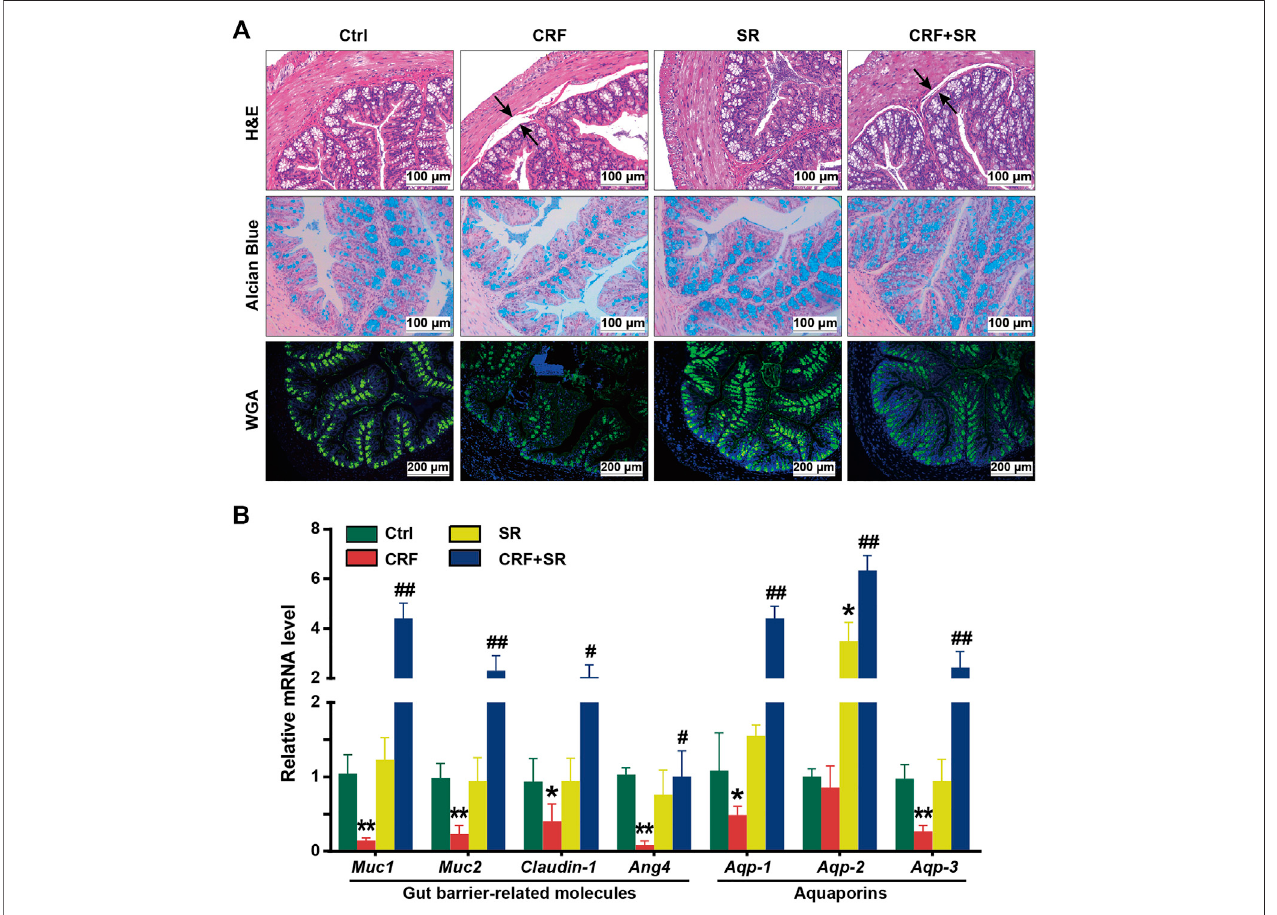
FIGURE 4 | Protection of gut barrier damage in colon of CRF mice by SR decoction. (A) Morphology of colon tissues by using H&E staining (200 ×), Alcian blue staining (200 ×), and WGA-FITC staining (100 ×). Black arrows, indicating intestinal edema. (B) Expressions of gut barrier-related molecules and aquaporins in colon tissues at mRNA level by RT-qPCR. Data were presented as mean ± SD (n = 6). *p < 0.05, **p < 0.01 vs. Ctrl group ; # p < 0.0 5, ## p < 0.01 vs. CRF group.